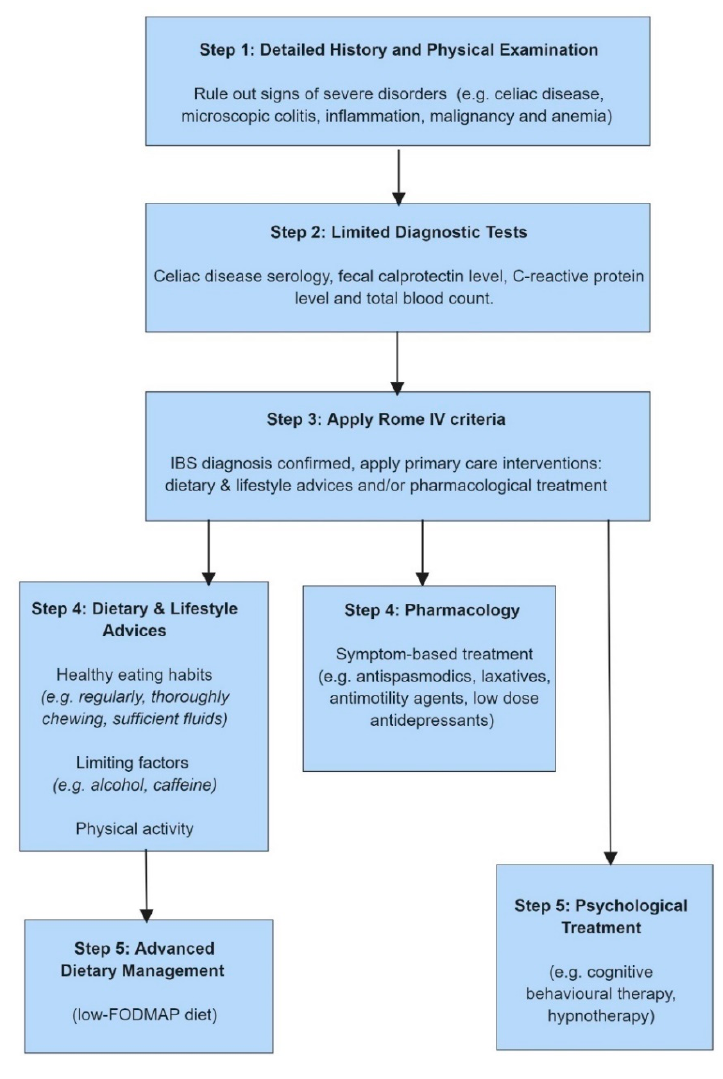
Figure 3. Diagnostic work-up and interventions in patients with IBS, derived from the NICE